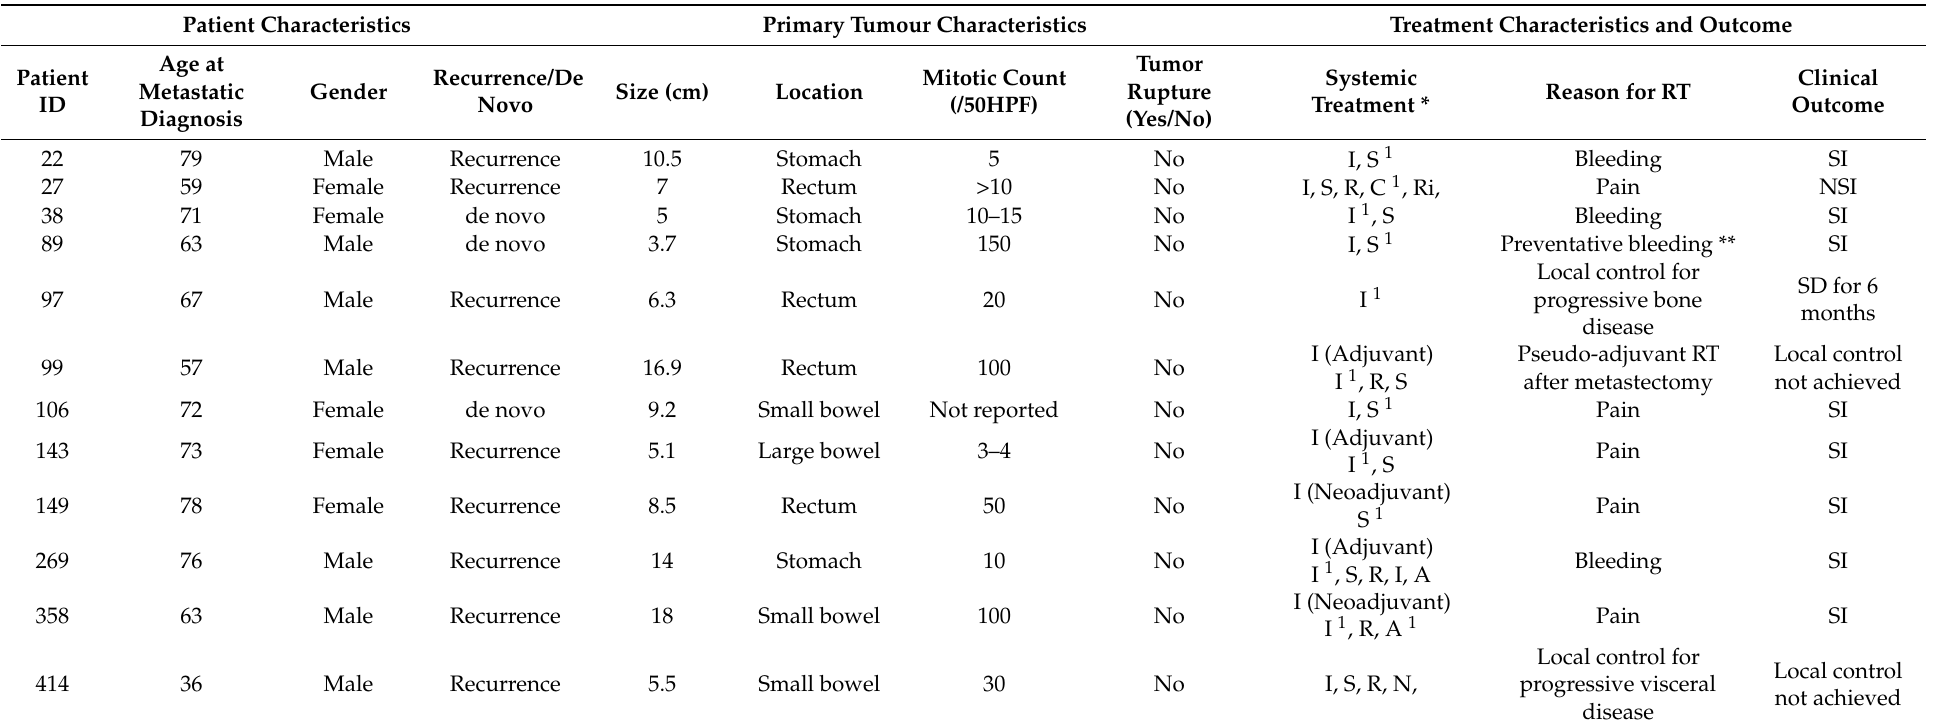
Table 2. Clinical characteristics and outcome of metastatic gastrointestinal stromal tumor (GIST) patients who underwent radiotherapy (RT). Patient Characteristics Primary Tumour Characteristics Treatment Characteristics and